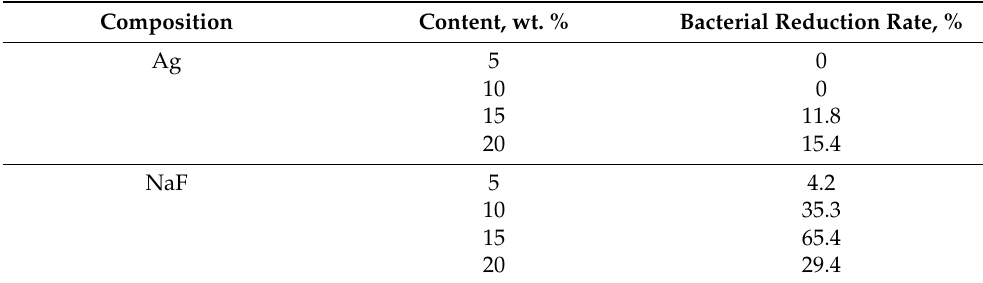
Table 1. Bacterial reduction rate for S. mutans on the surface of ZrO 2 disks coated by glass–ceramic powder containing Ag NPs and NaF after 24 h of